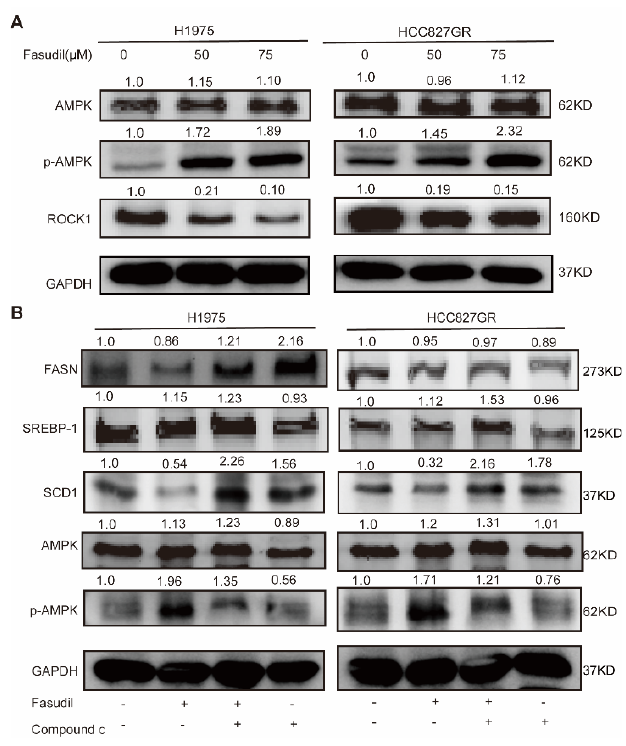
Figure 5. Effects of Fasudil on AMPK phosphorylations in gefitinib-resistant NSCLC cells. ( A ) H1975 and HCC827/GR cells were treated with Fasudil for 48 h. Western blot analysis of phosphorylation of AMPK and ROCK1 expression. ( B ) Phosphorylation of AMPK and FASN, SREBP-1, and SCD1 expression were also examined in the presence of compound C, an AMPK inhibitor. Each gene expression was normalized to glyceraldehyde-3-phosphate dehydrogenase (GAPDH). The uncropped blots are shown in Supplementary File S1.